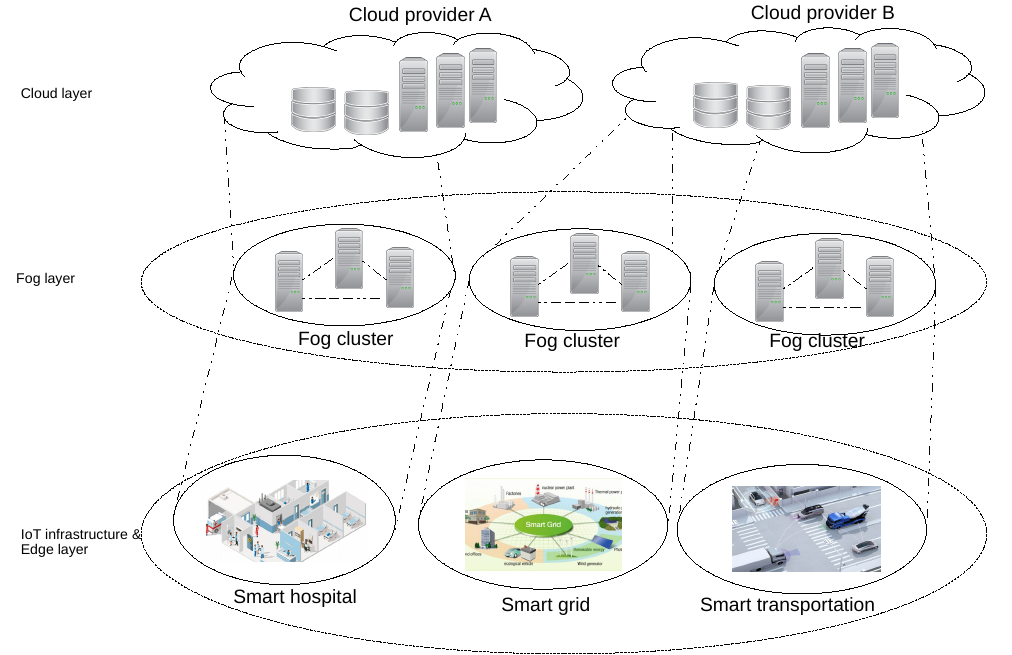
Figure 1. Smart city fog and cloud